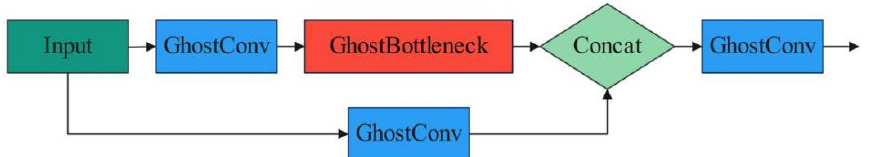
Figure 9. Structure diagram of C3Ghost (The arrows indicate the direction of forward propagation).